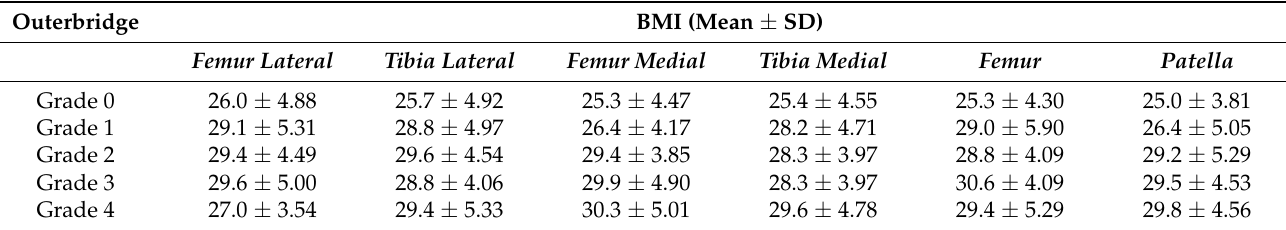
Table 5. BMI for the Outerbridge